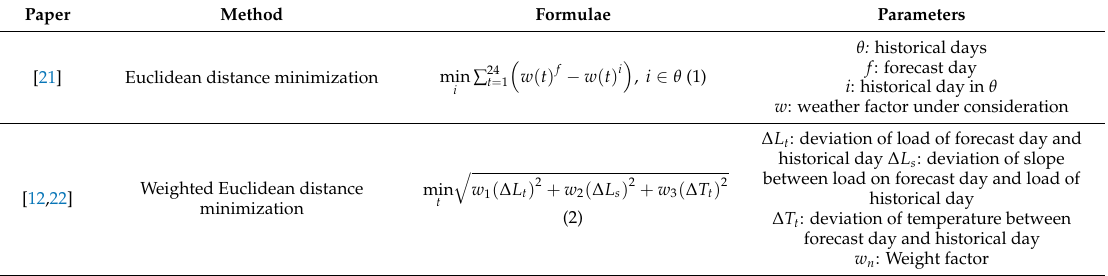
Table 1. Distance minimization technique for similarity measurement .